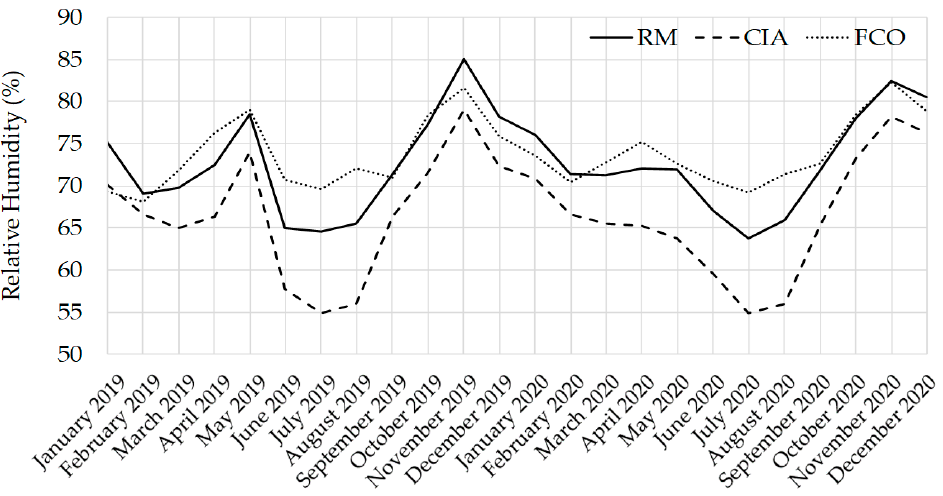
Figure 5. Monthly relative humidity values recorded in Rome, Fiumicino and Ciampino. Fiumicino, due to its position near the Tyrrhenian coast, has relatively higher humidity levels during the summer. In 2019, Rome recorded relative humidity values between 64.5% and 85.0%, while in 2020 the percentage range becomes equal to 63.8% and 82.5%, with an annual average of approximately 72.7%. In contrast, Fiumicino recorded annual average values of 73.7% in 2019 and 74% in 2020.